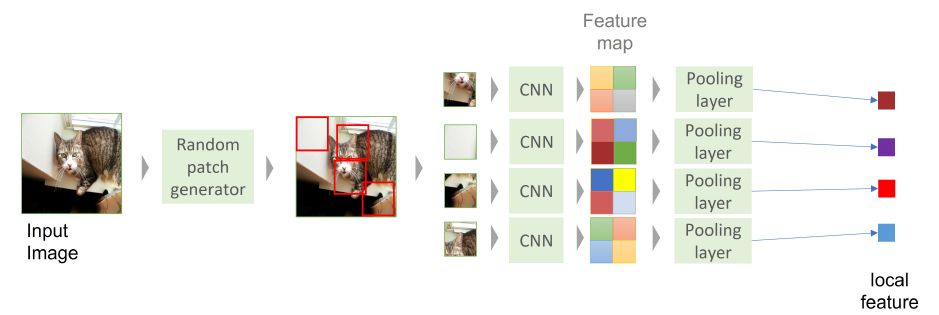
Figure 8. The pipeline of scene-level feature